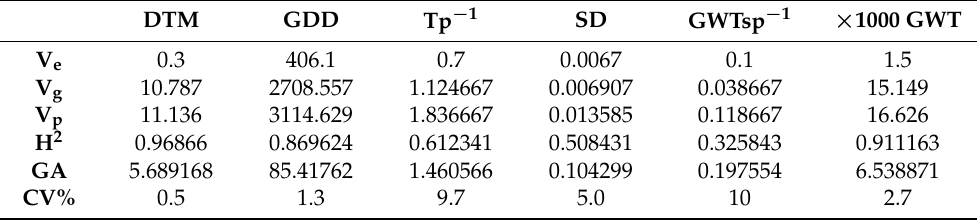
Table 5. Heritability, genetic gain and coefficient of variability.